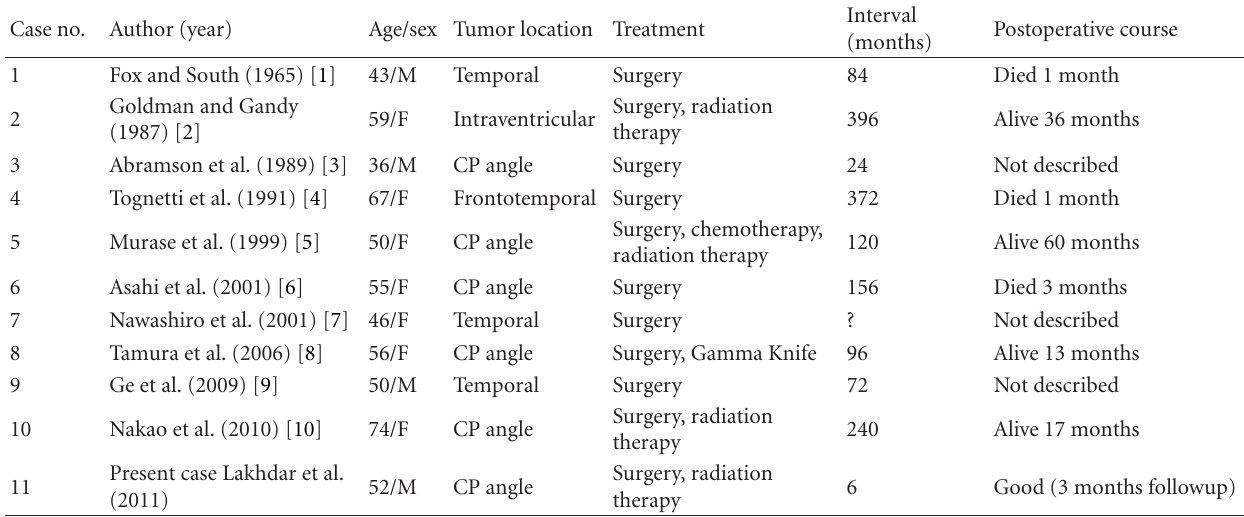
Figure 2: Axial (a) T1-weighted MRI with gadolinium and coronal; (b) T2-weighted MRI after the first surgery showing growth of the heterogeneous lesion with predominant enhancement and invading the surrounding structures. Table 1: Cases of malignant transformation of epidermoid